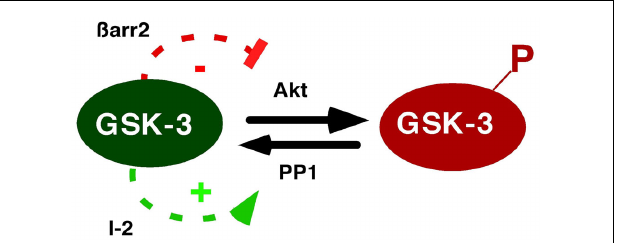
FIGURE 3 | Positive feedback regulation of GSK-3 through β -arrestin-2 and PP1. GSK-3 regulates its own activity by modulating its N-terminal phosphorylation state. As shown in Figure 2 , GSK-3 enhances stability of the β -arrestin-2 scaffold, leading to inactivation of Akt, and thereby reducing GSK-3 phosphorylation. In addition, PP1 dephosphorylates and activates GSK-3, but is inhibited by the PP1-specific inhibitor-2 (I-2). GSK-3 inactivates I-2, preventing PP1 inhibition, and thereby maintaining dephosphorylation of GSK-3.Thus GSK-3 activity is regulated by positive feedback loops involving β -arrestin-2 and